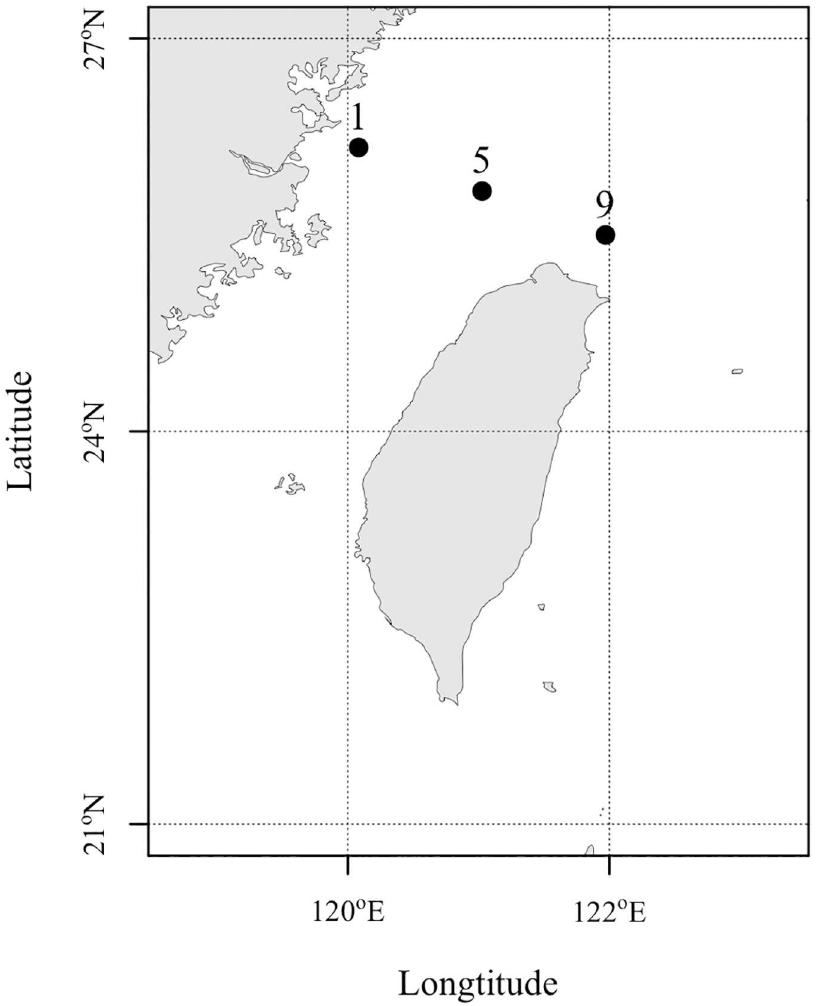
Fig 2. Map showing the three sampling stations in the East China Sea. Copepodnaupliiand copepodites samples were respectivelycollectedwith 50 and 100 μ m zooplankton net at 10 m depth at station 1, 5 and 9 in May,